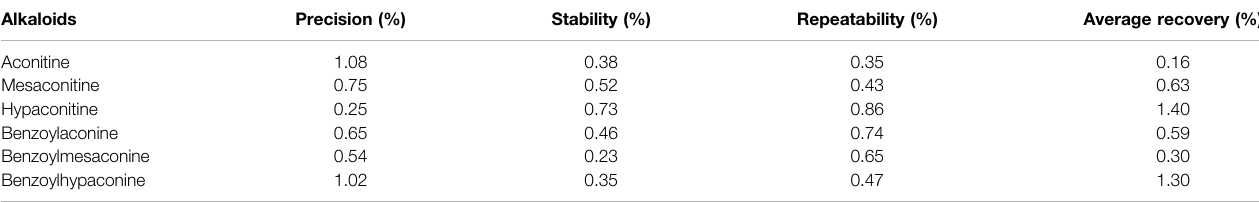
TABLE 2 | RSD of method evaluation for various alkaloids ( n (cid:2)